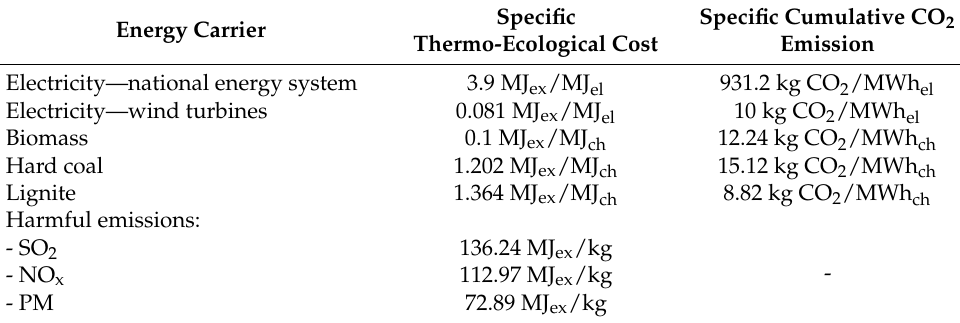
Table 4. Main input data for the analysis of Polish cases